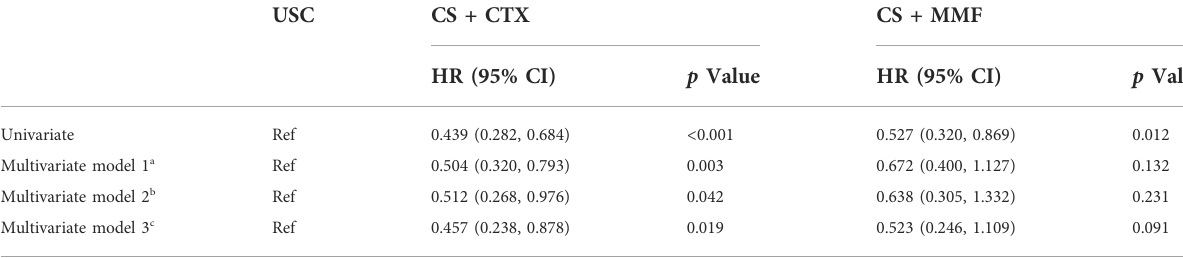
TABLE 2 Predictors of combined events in IgA nephropathy patients with stage 3 or four